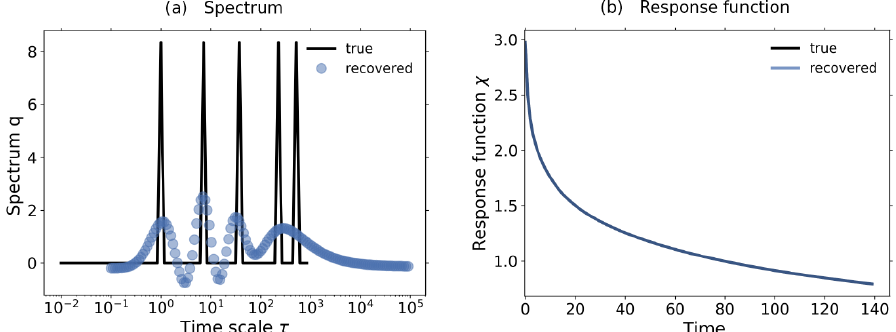
Figure E9. Spectrum q λ and response function χ(t) recovered from a 2 × f 0 experiment performed with the toy model described in Part 1 taking an underlying discrete spectrum with five timescales τ = 1, τ = 7, τ = 37, τ = 228, and τ = 518. The data were taken with SNR ∼ O ( 10 4 ) − O ( 10 5 )